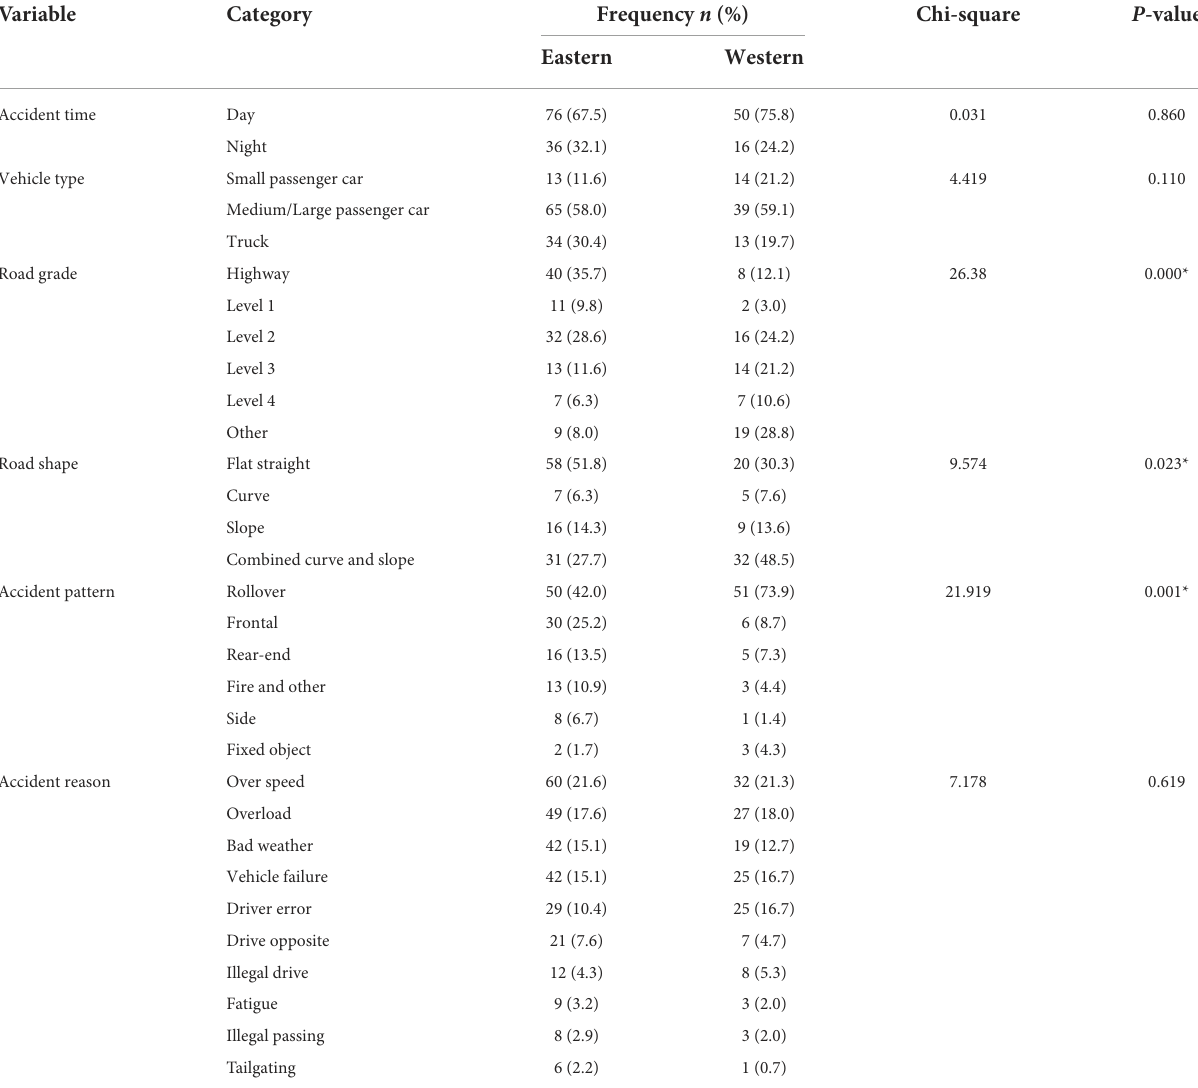
TABLE 3 Descriptive statistics in terms of the frequency, percentages, and chi-square analysis results.